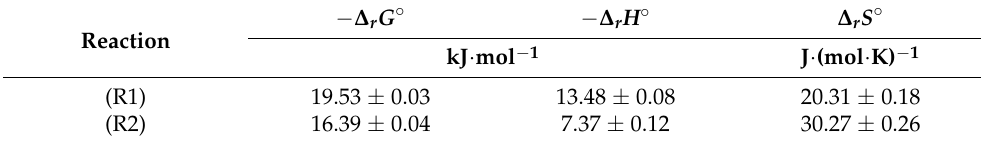
Table 3. Standard thermodynamic quantities of the reactions (R1) and (R2) in the ECCs at 298 K. Reaction